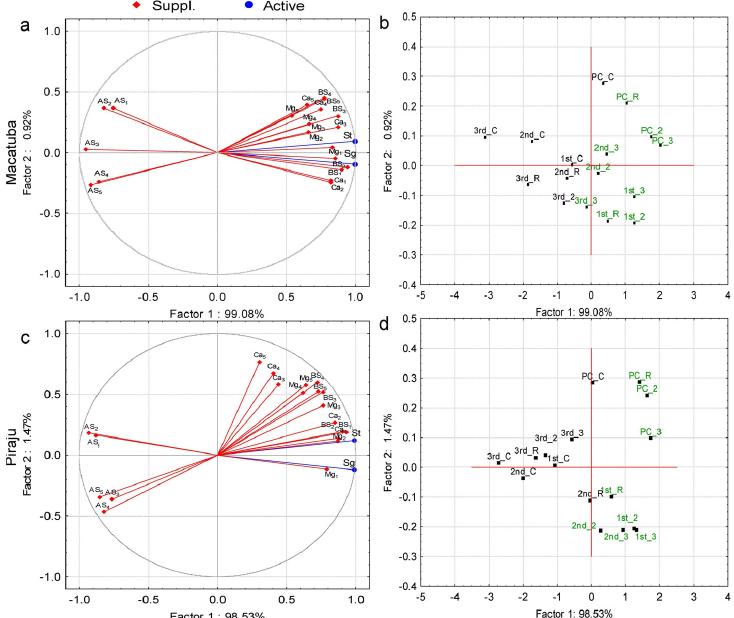
Figure 1. Projection of the dataset subjected to principal component analysis based on the correlations of stalk (St) and sugar (Sg) yields with ( a , c ) soil chemical attributes (Ca, calcium; Mg, magnesium; BS, base saturation; and AS, aluminum saturation) and depths (1, 0.0–0.2 m; 2, 0.2–0.4 m; 3, 0.4–0.6 m; 4, 0.6–0.8 m; and 5, 0.8–1.0 m); and ( b , d ) lime rate (C, control; R, recommended lime rate; 2, 2 × recommended lime rate; 3, 3 × recommended lime rate) at Macatuba and Piraju under conventional tillage (CT) for plant cane (PC) and first (1st), second (2nd), and third (3rd) ratoons.